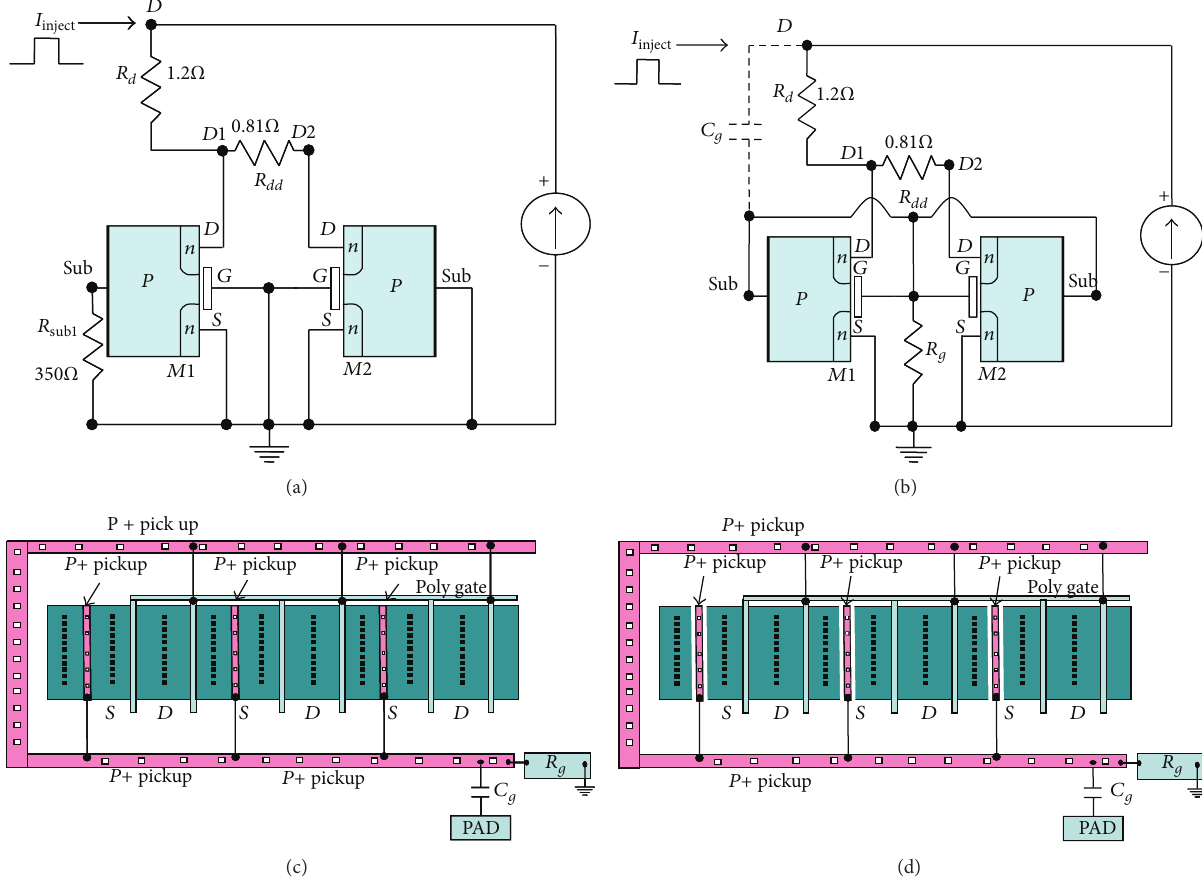
Figure 2: (a) The equivalent circuit for the gate-grounded multifinger ESD devices. (b) The equivalent circuit for the resistance and RC multifinger substrate-and-gate triggering devices. (c) The layout diagram of the RC SGTNMOS device with butting pickups in the NMOS source diffusions. (d) The layout diagram of the RC SGTNMOS device with inserted pickups in the NMOS source diffusions.